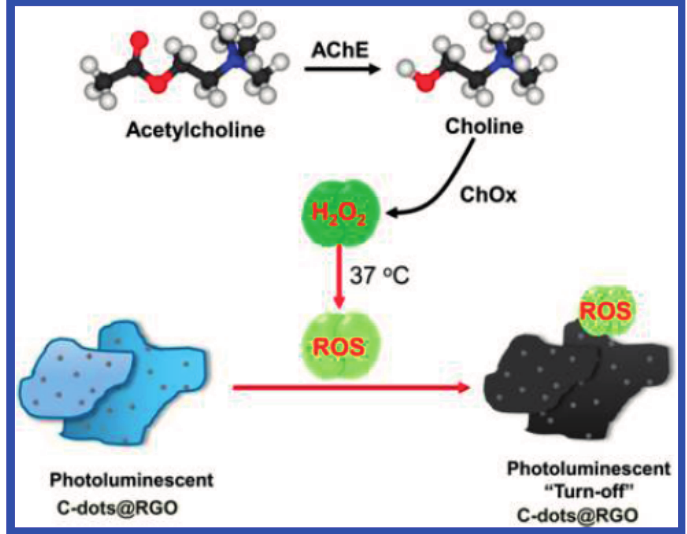
Figure 5. Schematic representation of sensing strategy of PL-quenched assay that uses C-dots@RGO for detection of ACh. Reprinted with permission from [51]. Copyright 2013 American Chemical